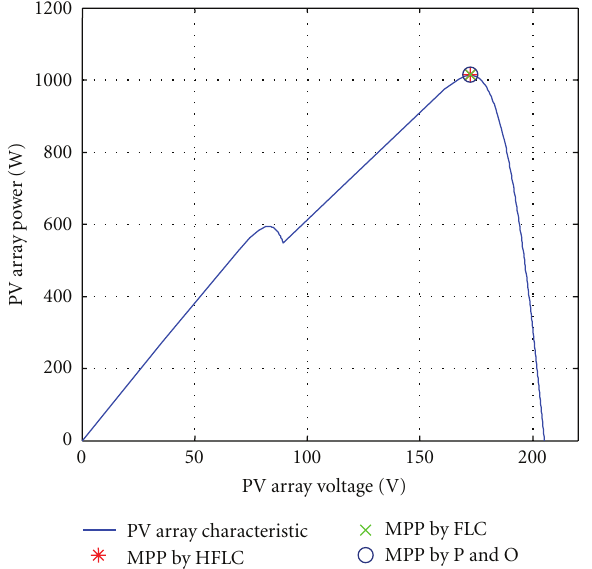
Figure 29: MPP under partial shading 800W/m 2 and 1000 W/m 2 .